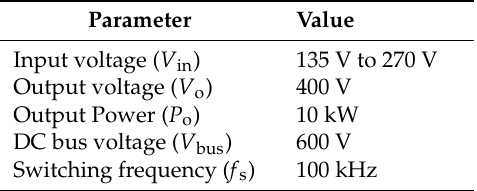
Table 2. Specifications of the designed converter